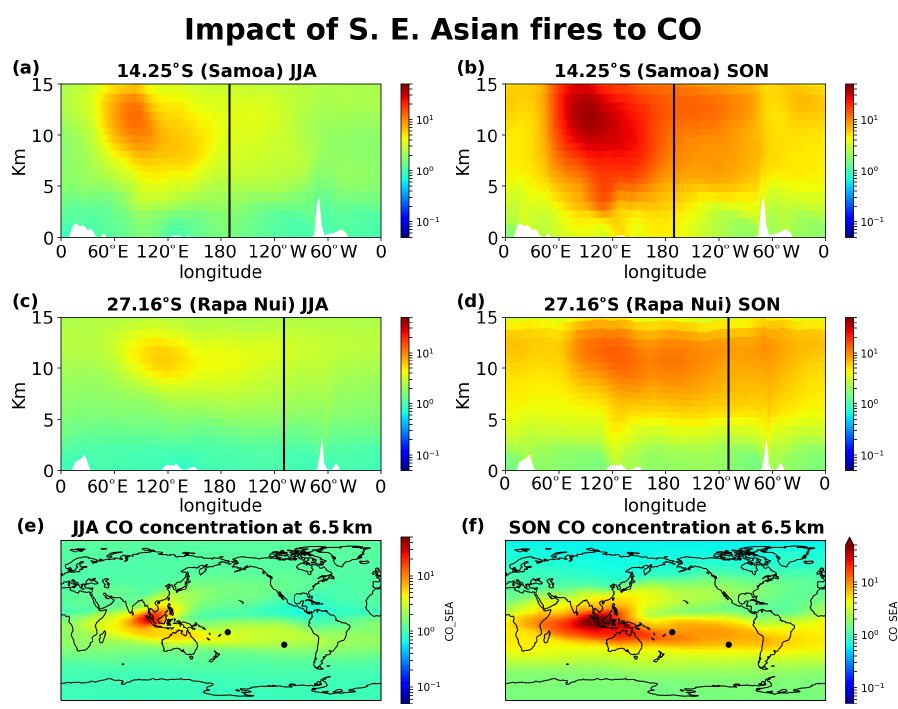
Figure 14. Impact of Southeast Asian fires on CO concentrations. (a) JJA and (b) SON 20-year mean impact at the cross section of Samoa,